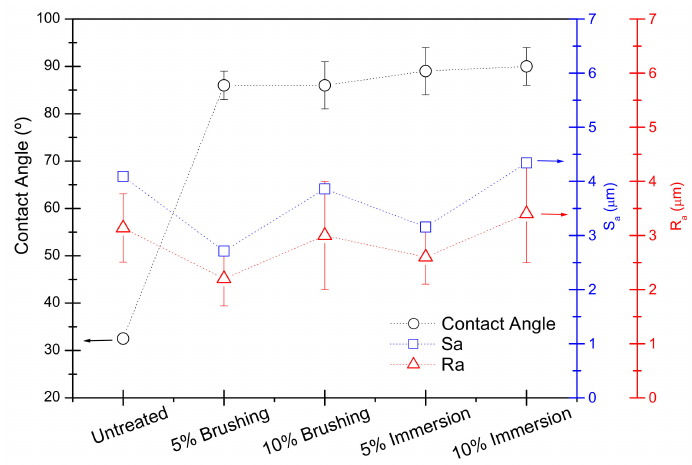
Figure 7. Comparative graph showing the variation of the contact angle and surface parameters for PVBVA-treated wood samples.